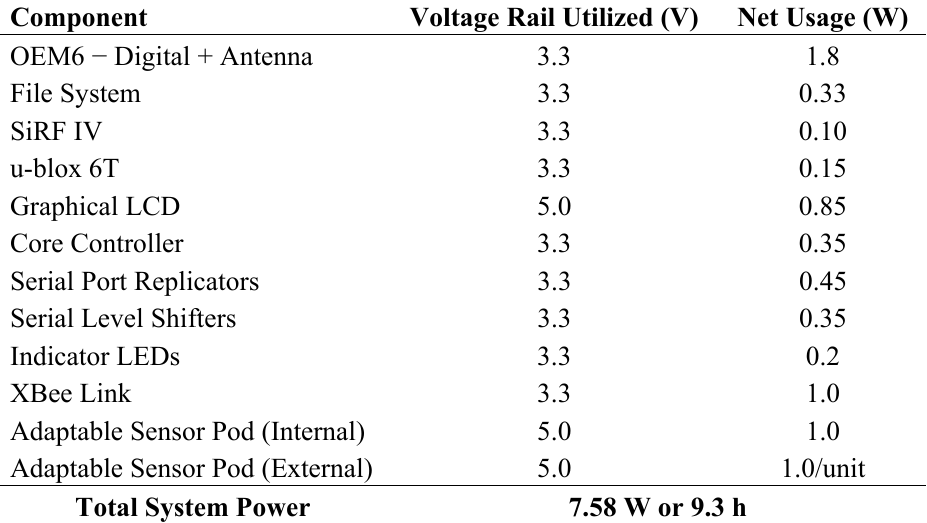
Table 3. NavCube Power Usage by Component Type.